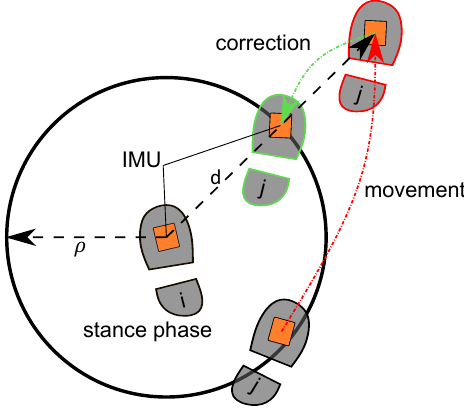
Figure 6. Concept of spatially constraining a dual foot-mounted inertial navigation system (INS) in 2D using a maximal possible separation ρ . The actual computed distance is denoted as d . (Adapted from